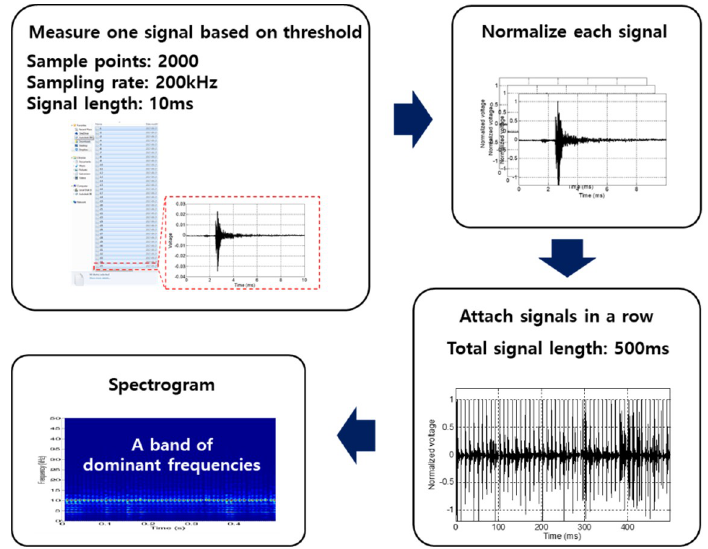
Figure 9. Applied signal processing scheme to visualize frequency information.